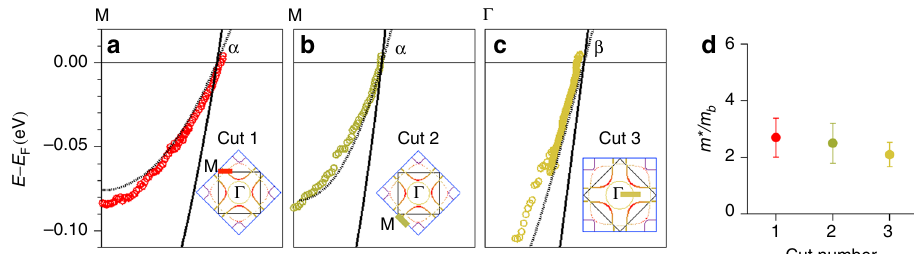
Fig. 3 Low-energy electron dynamics. a – c Experimental band dispersions ( colored dots ), where the cut positions are indicated in the insets. The solid black curves are the calculated dispersions from DFT theory for the relevant bands. The dotted black curves are the DFT bands scaled by the corresponding mass enhancement values. d The measured mass enhancements of each band, which are all roughly 2 – 2.5. The error bars denotes the s.d. of the